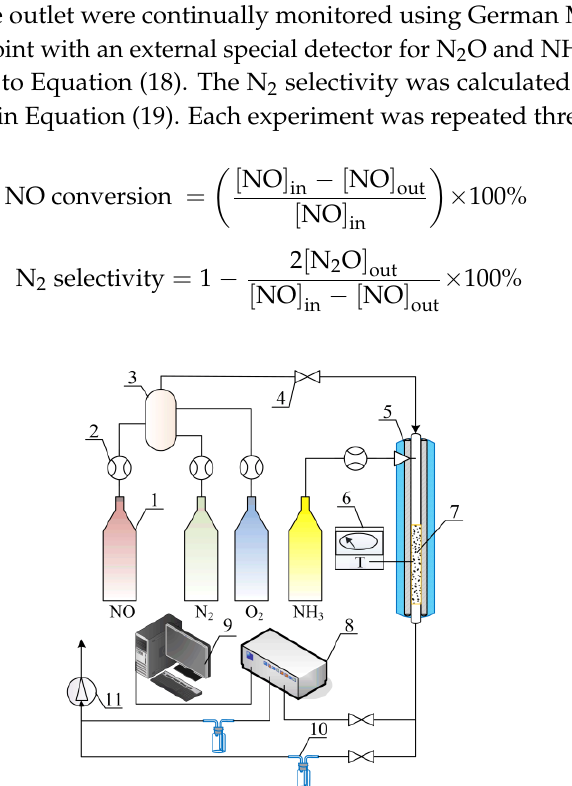
Figure 10. The schematic diagram of SCR experiments. 1, standard gas; 2, mass flowmeter; 3, gas